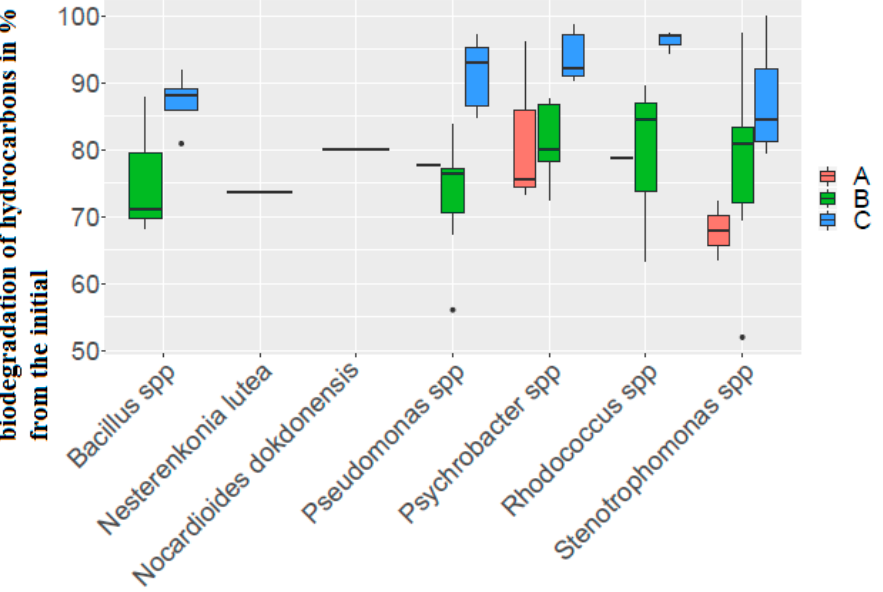
Figure 5. Biodegradation of hydrocarbons by strains isolated from the gas-hydrate region. (A) The degree of biodegradation of oil by strains capable of utilizing oil only under aerobic conditions; (B) the degree of oil biodegradation by strains capable of utilizing oil both under aerobic and anaerobic conditions (aerobic conditions); (C) the degree of oil biodegradation by strains capable of utilizing oil both under aerobic and anaerobic conditions (anaerobic conditions). The corresponding data can be found in Table S2.